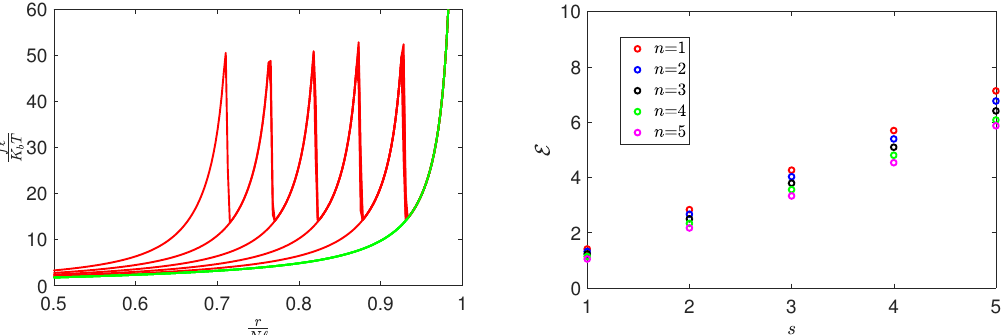
Figure 10. Helmholtz force–extension response (left panel, red curves) and extra-toughness (right panel, colored symbols) for a chain with different s and n . We also added the response of the same system without sacrificial bonds in order to compare the different behaviors (green curve). On the left panel, we considered a chain with s = 1,...,5 with the fixed value n = 3. On the right panel, the extra-toughness is calculated for n = 1,...,5 and n = 1,...,5. The plots are represented with adimensional quantities. The other parameters are given by N = 50, h / k = 1, E / ( K b T ) = 75, and d / (cid:96) =